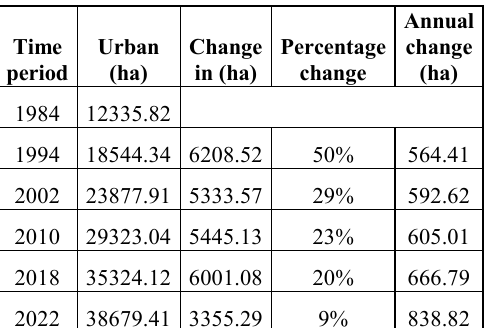
Table 3. The best results of the calibration through the phases